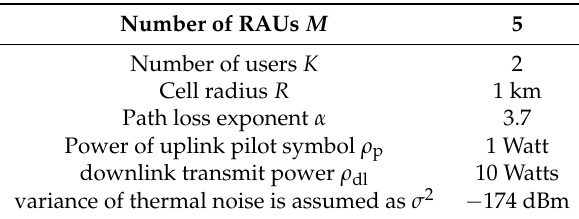
Table 1. Basic simulation